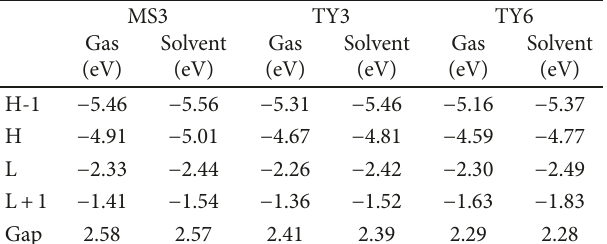
Table 2: Frontier molecular orbital energies and energy gaps of MS3, TY3 and TY6.